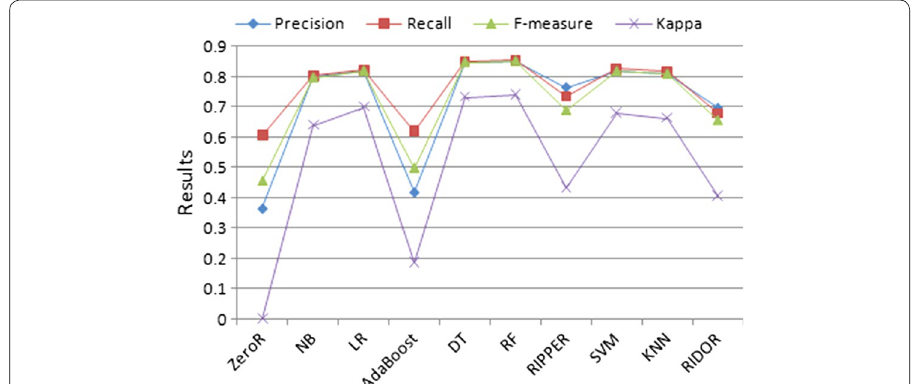
Fig. 1 Effectiveness comparison results for different machine learning classifier based context-aware models utilizing dataset